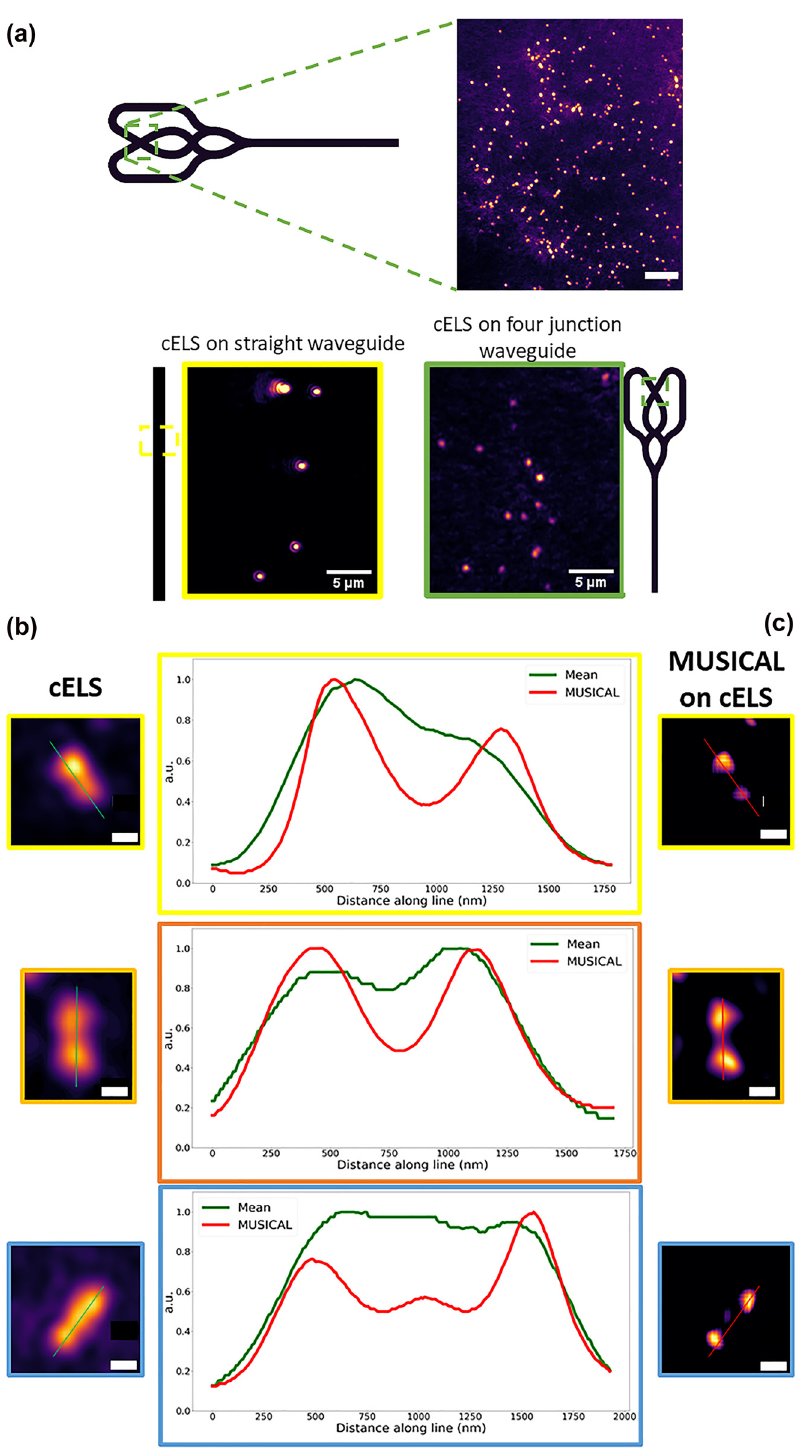
Figure 7: cELS on four arm junction waveguide and application of intensity fluctuation algorithm to cELS images. (a) Four arm junction waveguide used for the experiments. 100 nm polystyrene beads imaged in cELS mode using a four-arm crossing waveguide is given, scale bar 10 μ m. The green dotted box in the waveguide shows the imaging region. The use of a four-arm crossing waveguide mitigates the coherent scattering noise as shown by the images of 100 nm polystyrene beads imaged using straight and four crossing waveguides. Scale bar 5 μ m. (b) Three different regions of interest of 100 nm polystyrene beads imaged in cELS mode. (c) The corresponding MUSICAL reconstruction is shown. A stack of 100 images is given as input for MUSICAL. Three separate regions of interest in yellow, orange, and blue boxes in cELS and the corresponding MUSICAL reconstructions are shown side by side. The line profiles of the regions are given as well. Scale bar 500